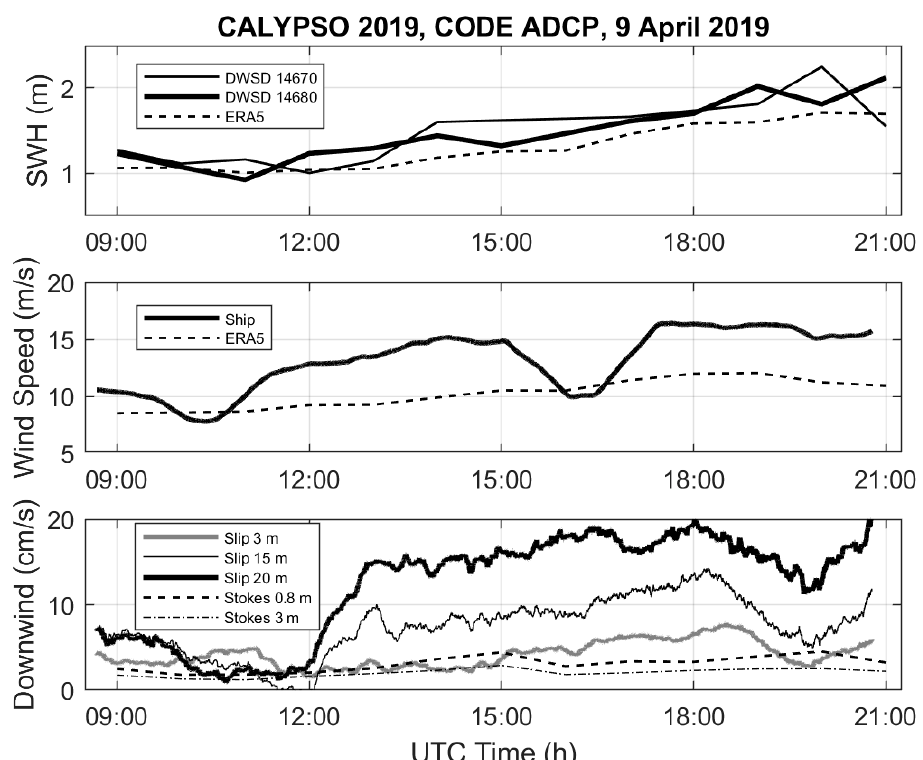
Figure 8. Significant wave height (top panel ; DWSD TM 14670—thin, DWSD TM 14680—thick, ERA5—dashed), wind speed ( middle panel ; ship—solid, ERA5—dashed) and downwind slip of the CODE with respect to the currents at 3 m (gray), 15 m (thin black) and 20 m (thick black), measured by the ADCP versus time on 9 April 2019 ( bottom panel ). The downwind slips ue to the Stokes drift shear between 0.8 m and 3 m (dashed–dotted) and 15 m (dashed) are also shown.